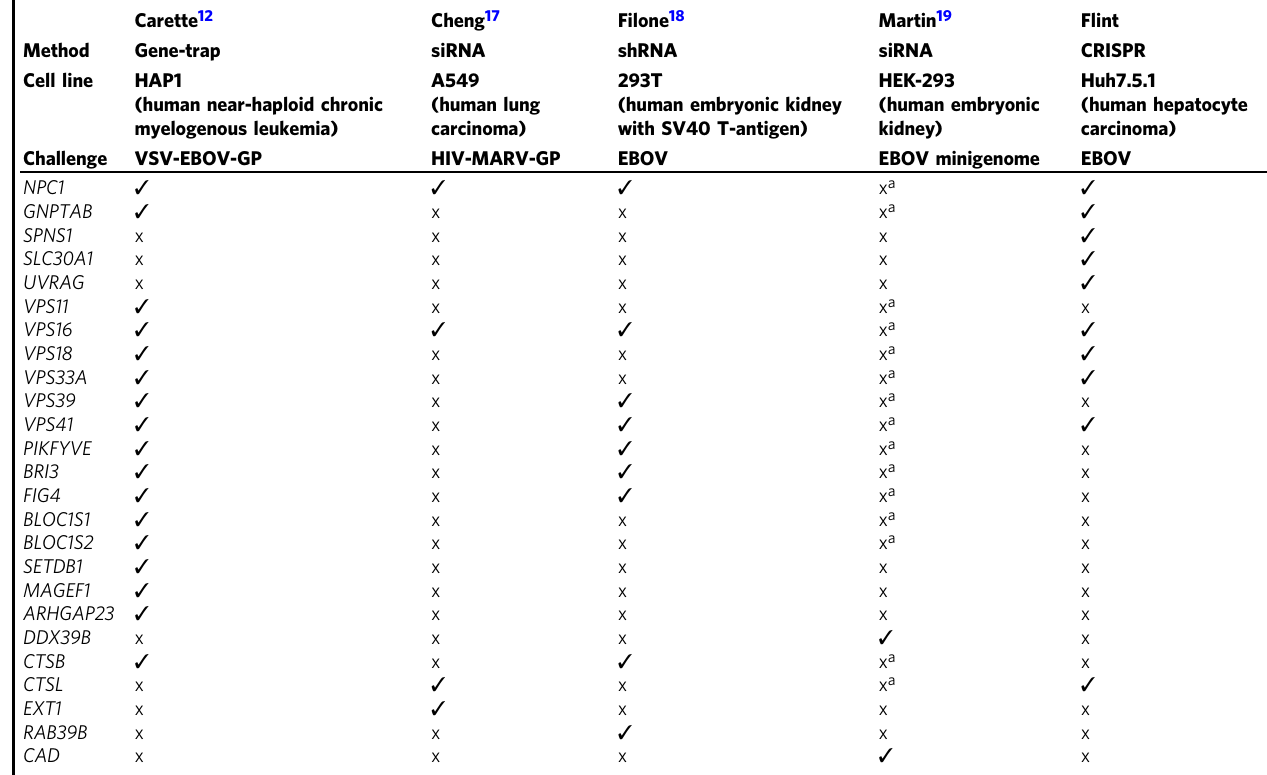
Table 2 Comparison of the CRISPR-Cas9 screen with previously reported screens Carette